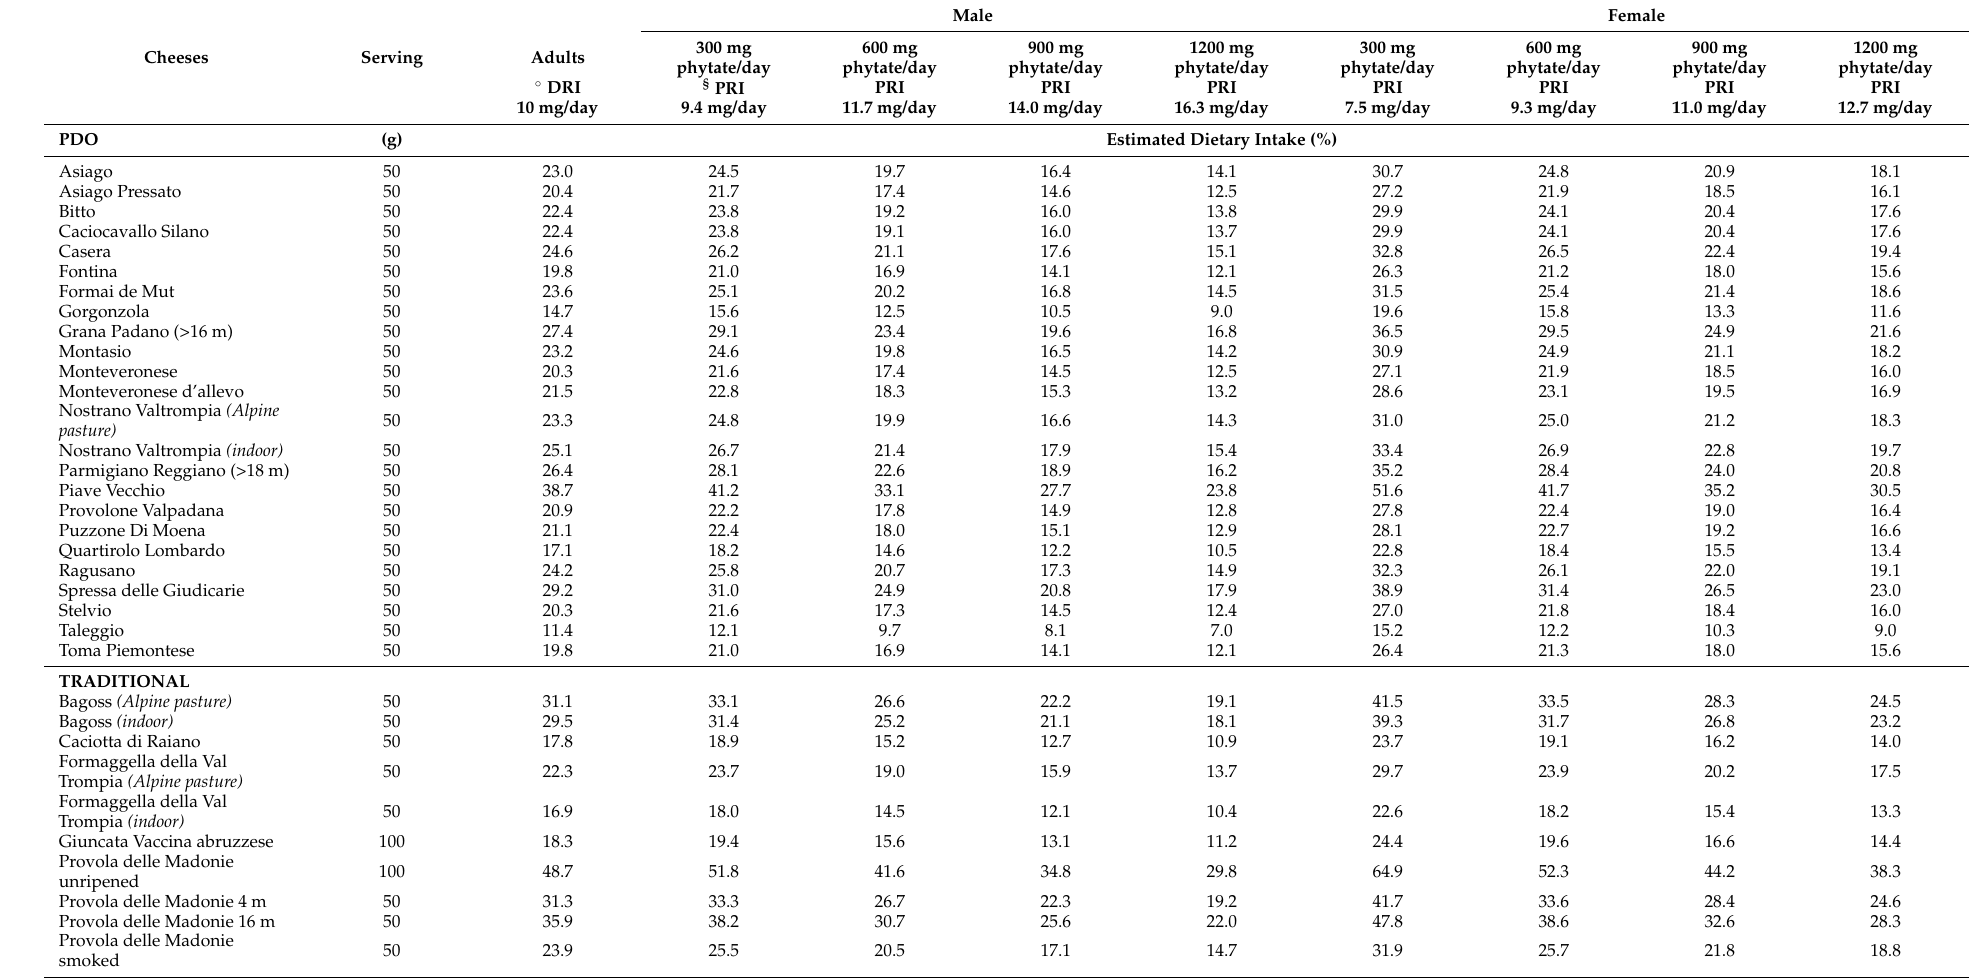
Table 4. Estimated Dietary Intake (%) of zinc in adults calculated according to the reference values of EU [28] and EFSA [13], with a serving (50 g or 100 g) of cheese from cow milk. Male Female Cheeses